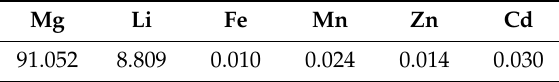
Table 1. Analysis of Mg-9Li alloy composition (wt.